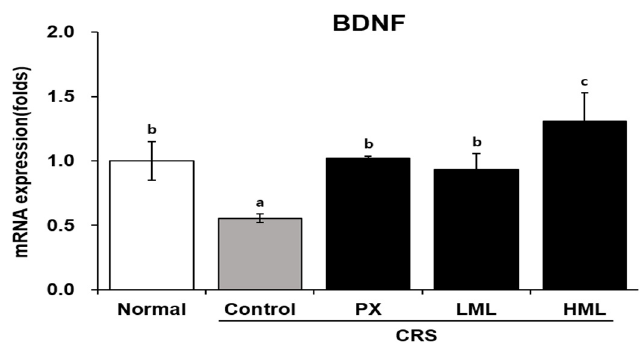
Figure 4. E ff ect of the ML extracts on BDNF mRNA expression in brain tissue. Mice were restrained for 2 h for 28 consecutive days after treatments. BDNF mRNA expression was measured by real-time PCR. Data represent means ± SEM ( n = 5). Di ff erent letters (a–c) above the bars indicate significant di ff erences at p < 0.05. CRS—chronic restraint stress; PX—paroxetine; LML—low-concentration mustard leaf; HML—high-concentration mustard leaf; BDNF—brain-derived neurotrophic factor.